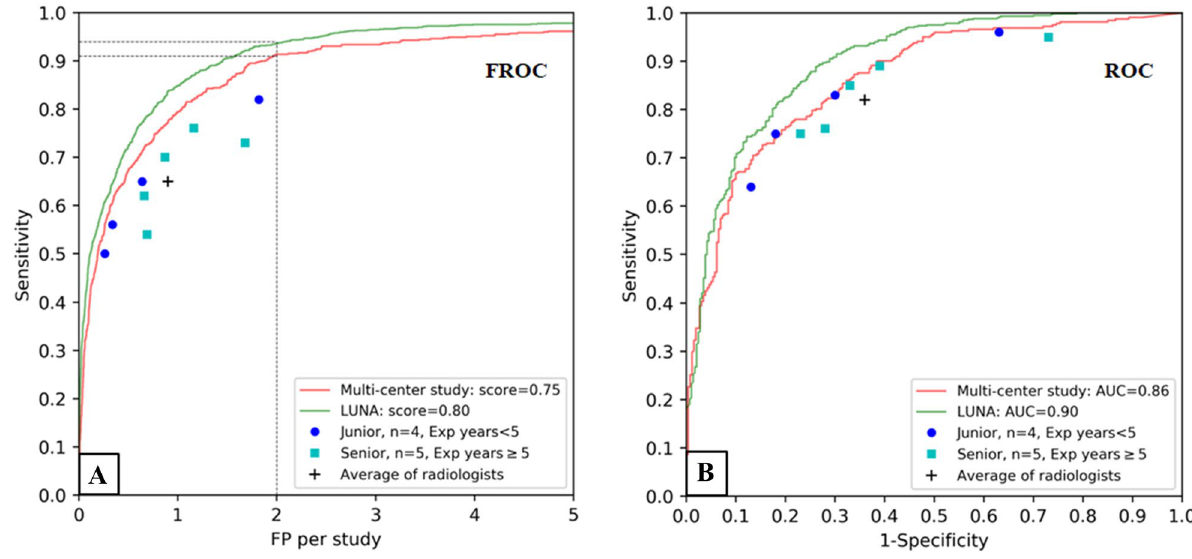
Figure 4. Performance assessment of the DL algorithm with FROC curves and ROC curves. Two assessment tasks, namely, nodule identification and classification for positive cases, are shown in the FROC and ROC curves, respectively. ( A ) FROC curves of the DL algorithm vs. individual or average performance of junior and senior radiologists assessed in the task of nodule identification. The DL algorithm outperformed all individual radiologists and the average radiologist performance in this task. ( B ) ROC curves of the DL algorithm vs. radiologists in the task of classification of positive cases. The performance of the algorithm was better than the average performance of the radiologists. The FROC scores and the AUC values showed slightly better performance of the algorithm on the LUNA test set than on the multi-centre validation set (FROC scores: 0.80 vs. 0.75; AUC values: 0.90 vs. 0.86). FROC freeresponse receiver operating characteristic, ROC receiver operating characteristic, AUC area under the curve, FP false